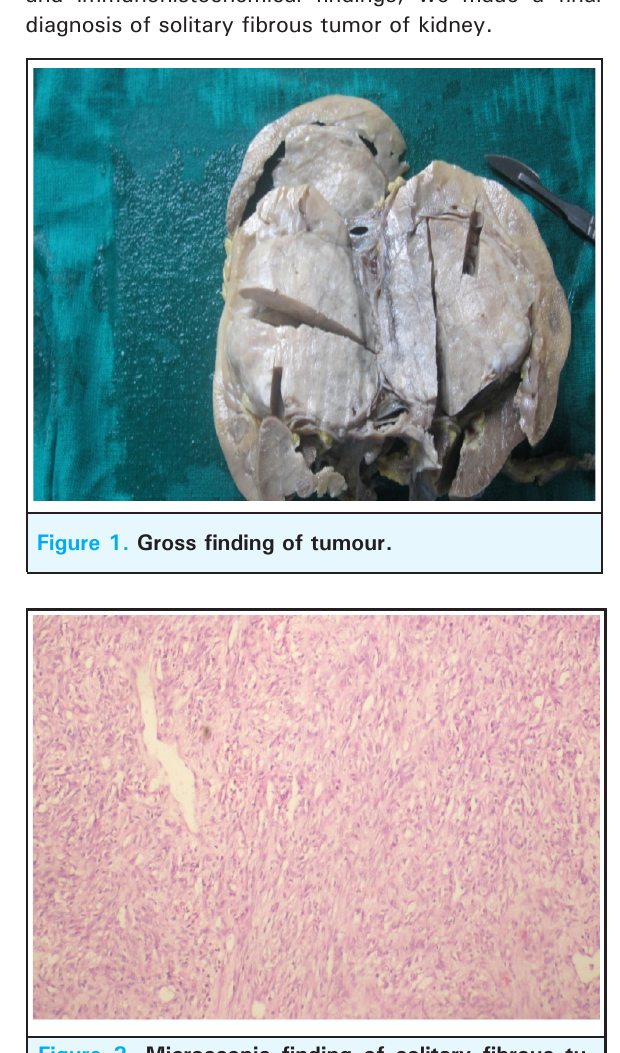
Figure 2. Microscopic finding of solitary fibrous tu - mour (H and E